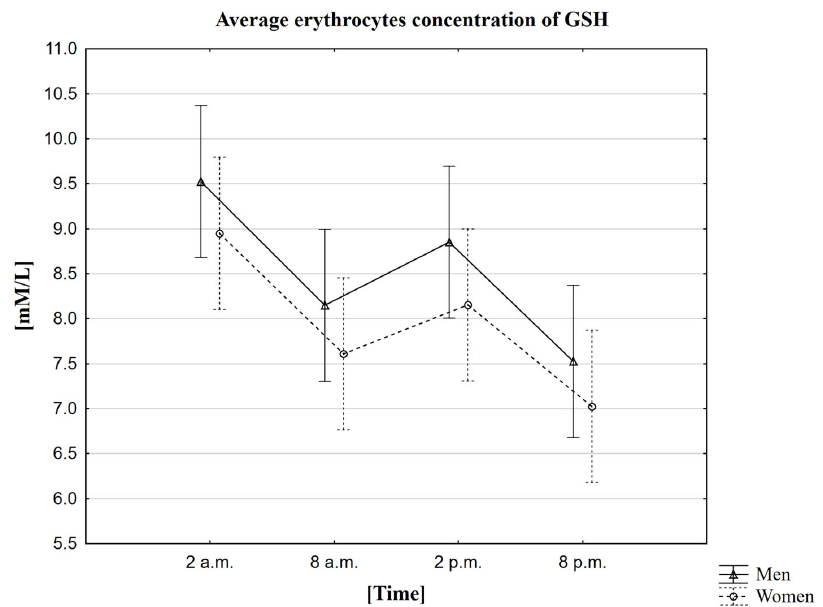
Figure 7. Average erythrocytes concentration of GSH in men and women at different sampling time points. Data presented as mean ± 95% confidence interval. MANOVA ‐ type analysis ( p = 0.99631).